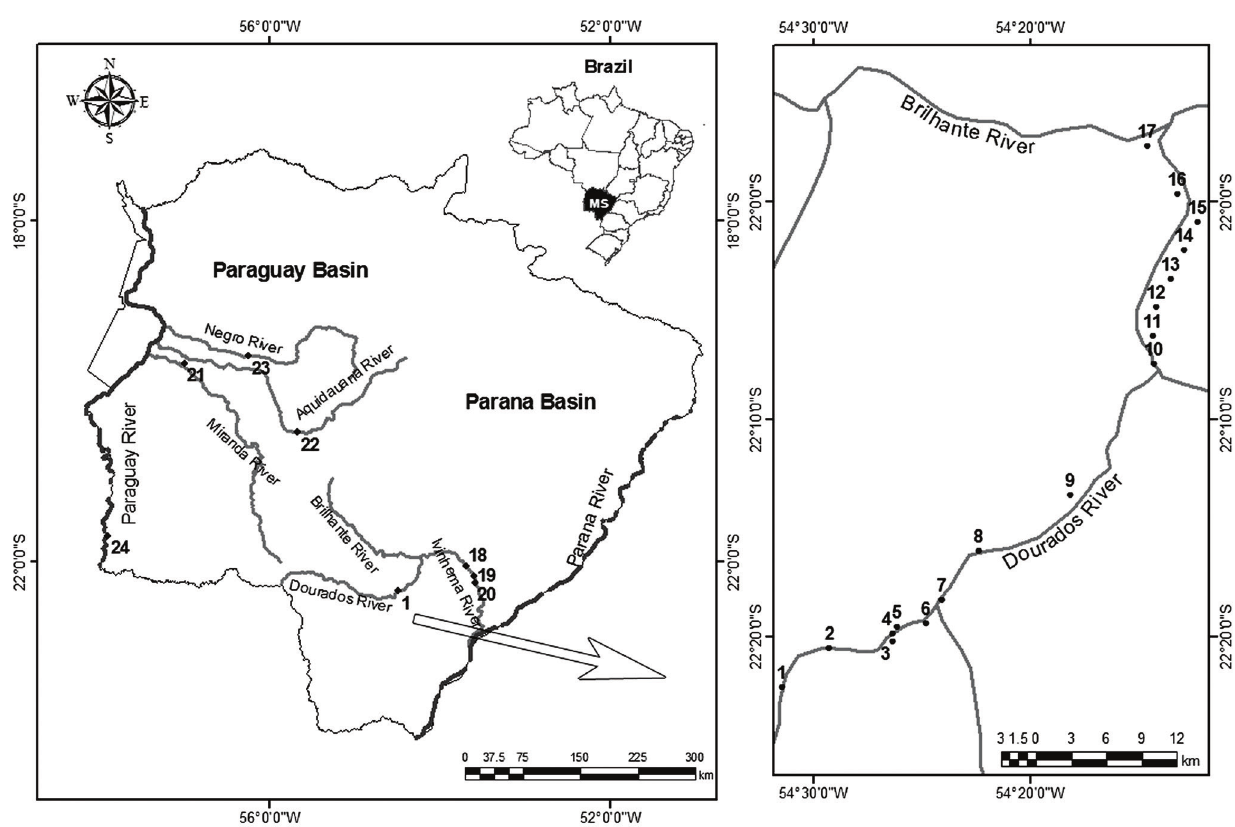
Fig. 1. Map of collection sites of the biological material. Upper Paraná River basin: Dourados River (1 to 16), Brilhante River (17), and Ivinhema River (18 to 20). Paraguay River basin: Miranda River (21), Aquidauana River (22), Negro River (23), and Paraguay